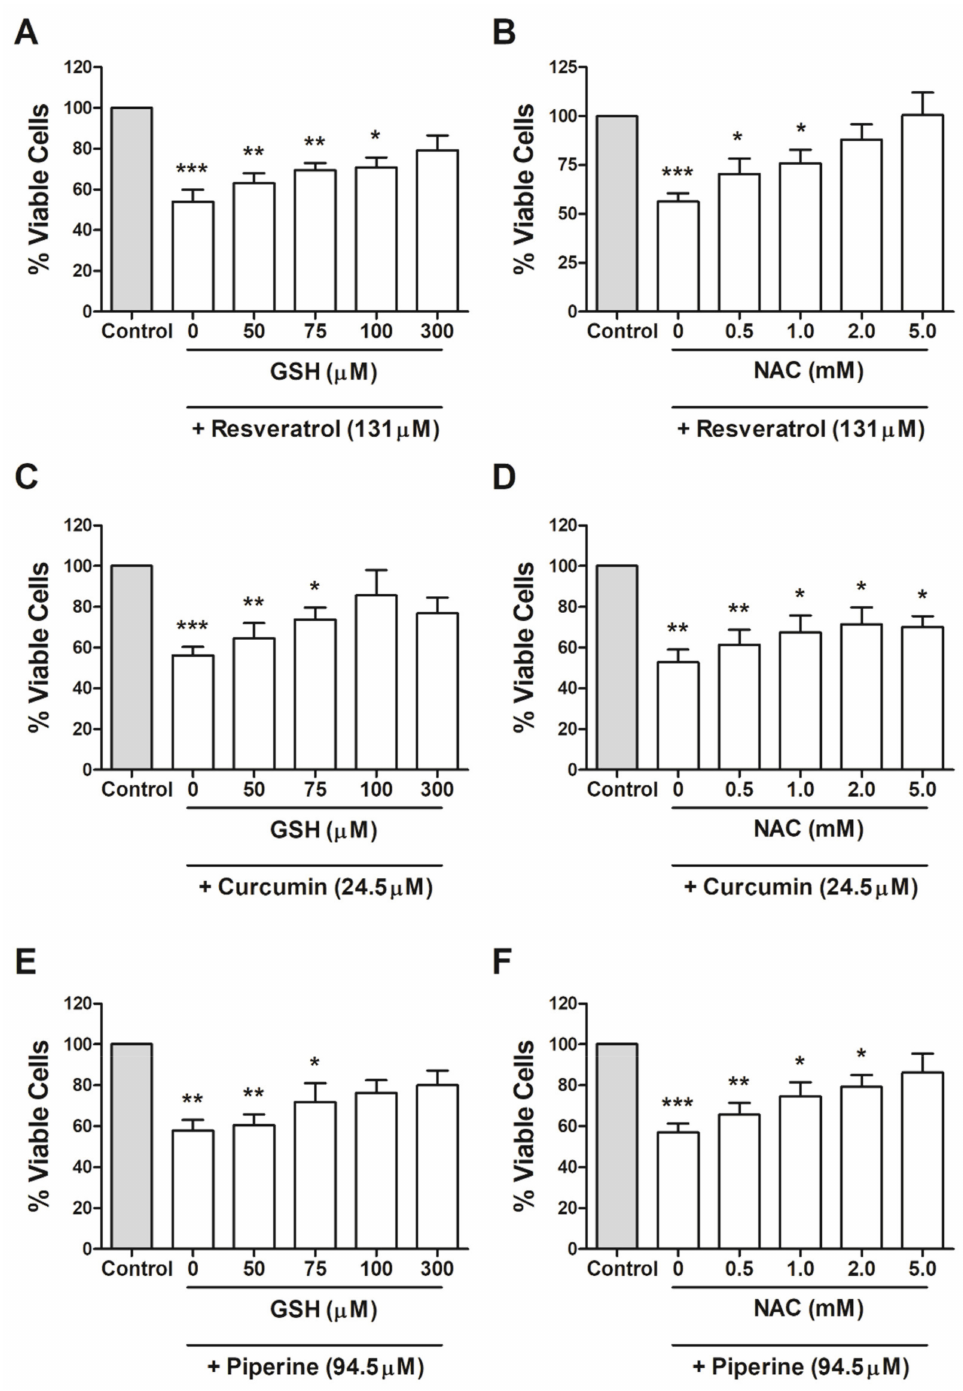
Figure 3. Protective e ff ect of glutathione (GSH) and N-acetyl-cysteine (NAC) on MCF-7 cell viability after resveratrol, curcumin and piperine treatment: Cells were treated with 50, 75, 100 and 300 µ M of GSH or 0.5, 1.0, 2.0 and 5.0 mM of NAC, and 131.0 µ M resveratrol ( A , B ), 24.5 µ M curcumin ( C , D ) or 94.5 µ M piperine ( E , F ) were added after 30 min,. After 24 h, cell viability was determined by the MTT assay. The results are representative of three experiments performed in triplicate ± SEM. * p < 0.05, ** p < 0.001, and *** p < 0.0001 in relation to the